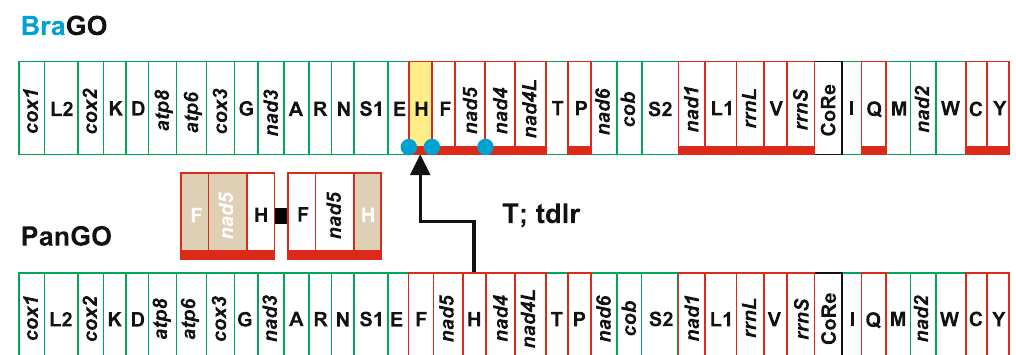
The mitochondrial genome (mtDNA) of Crustacea is usually a double helical and circular molecule spanning 15–18 kb 7 . The most noftable exception is represented by several Isopoda mtDNAs consisting in a combination of a linear molecule approximately 14 kb long, and a circular molecule, made by two linear molecules connected in a head-to-head arrangement 8, 9 .